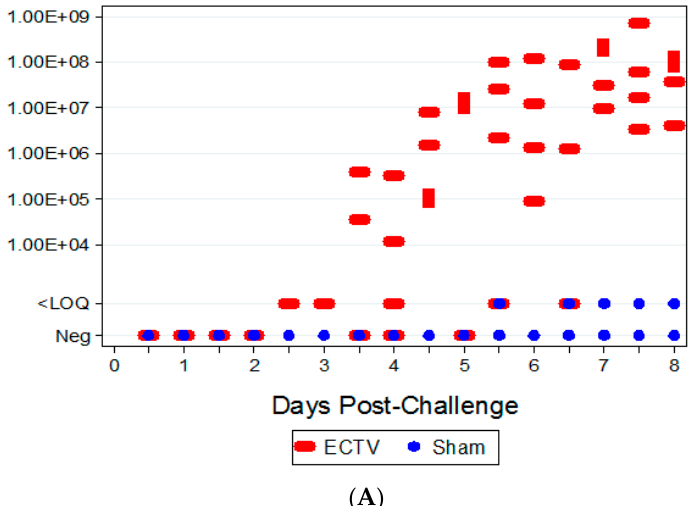
Figure 6. Cont . Figure 6.